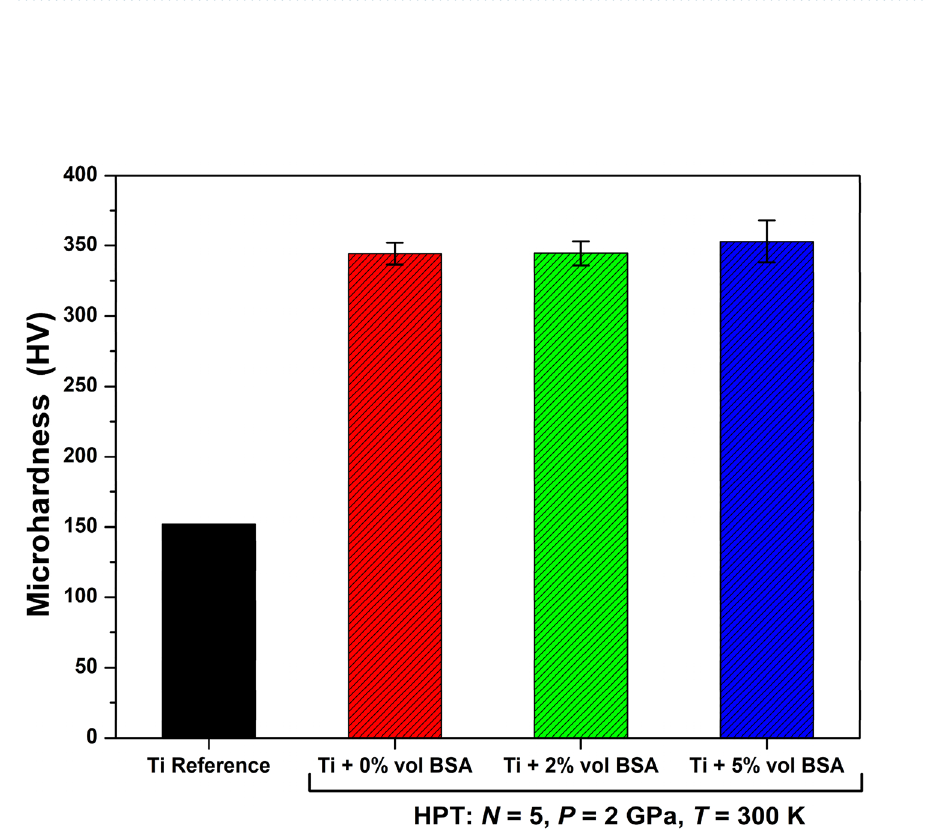
Figure 4. Vickers Microhardness for pure titanium and for nanocomposites containing 2 and 5 vol% of BSA produced by 5 turns of HPT under 2 GPa in comparison with hardness of coarse-grained annealed